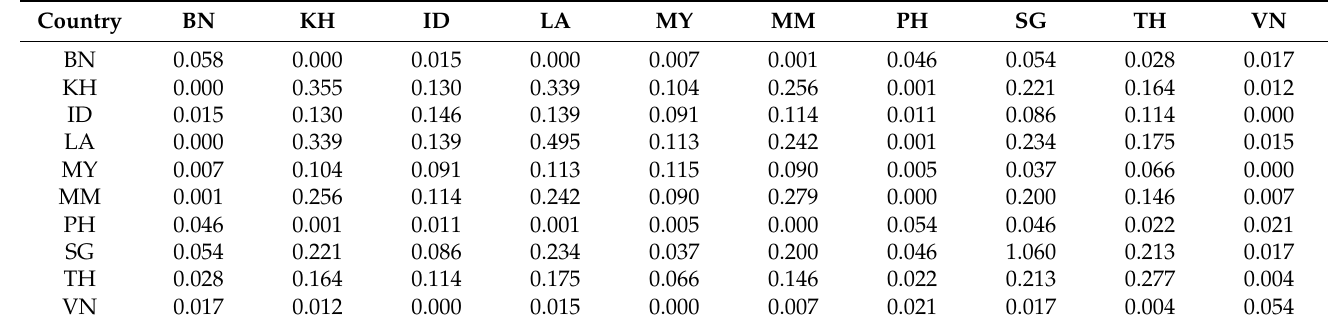
Table A3. The distance variance matrix of alternatives according to indicator C1.